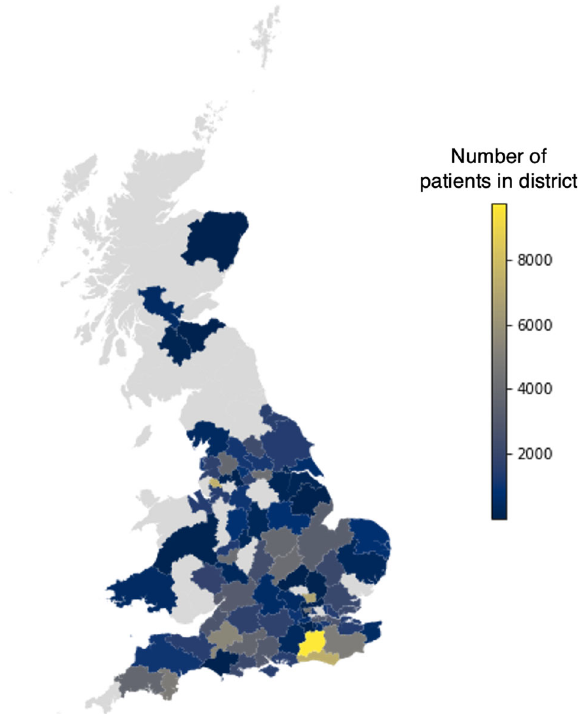
Fig. 3 Geographic distribution of patient postal districts sub- mitted to the Vaximap service between January 2021 and May 2022. Grey denotes no data. Figure produced by the authors using Tableau Public https://public.tableau.com/app/discover.